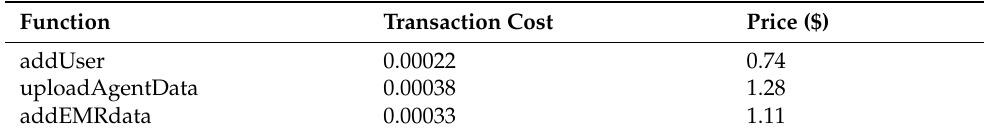
Table 2. Gas price of some transactions of our proposed system.